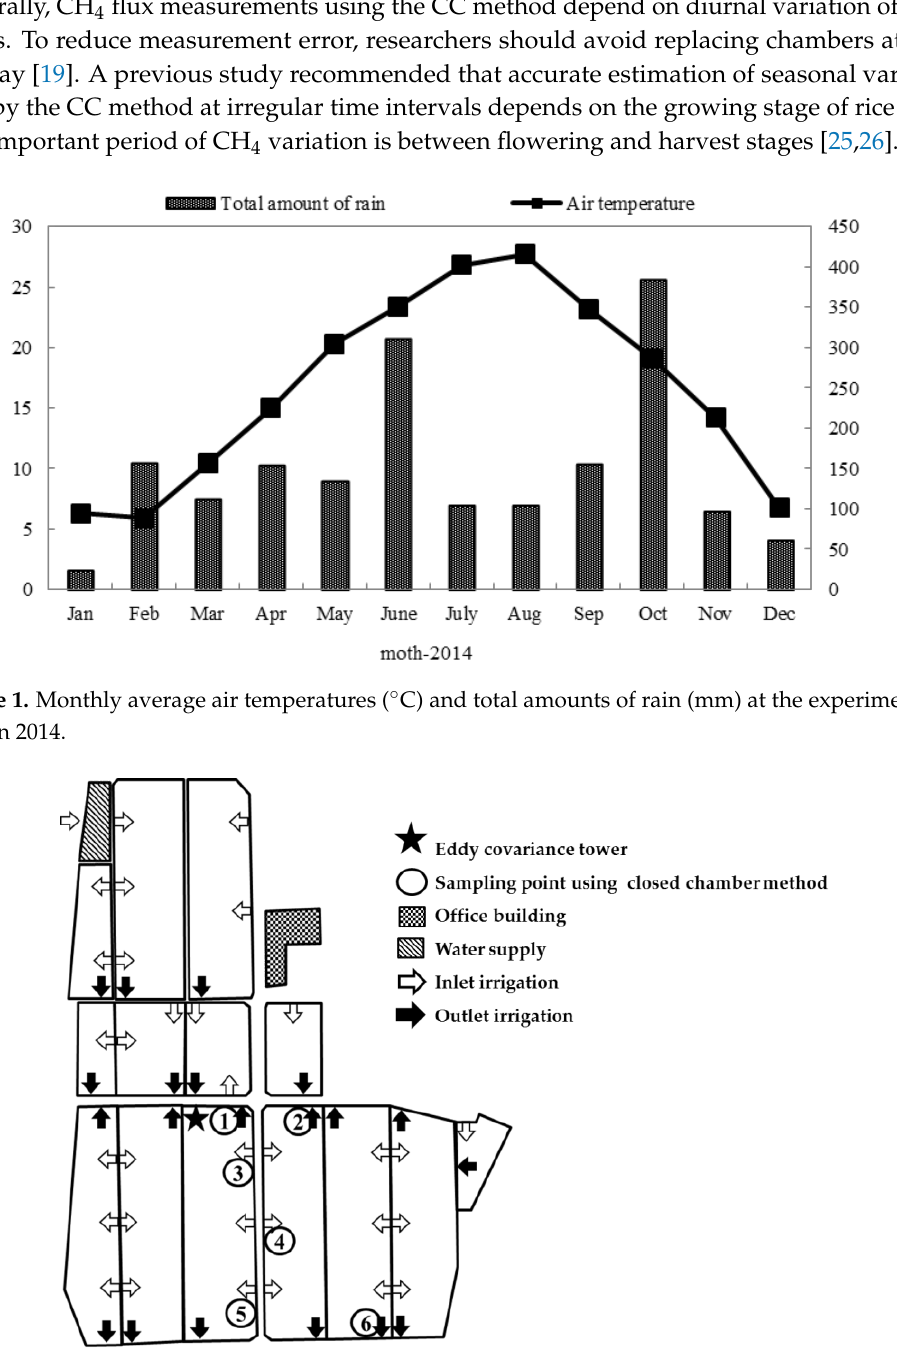
Figure 2. Layout of the paddy rice field experimental site containing 13 individually irrigated fields. The black star indicates the location of the eddy covariance tower, and the circled numbers indicate closed chamber sampling points. The empty and black arrows show inlet and outlet irrigation systems, respectively.